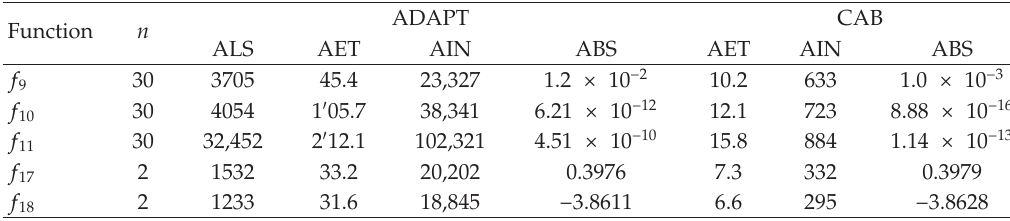
(cid:2) n ∈ { 2 , 10 , 30 , 50 , 70 , 100 , 120 } (cid:3) of f